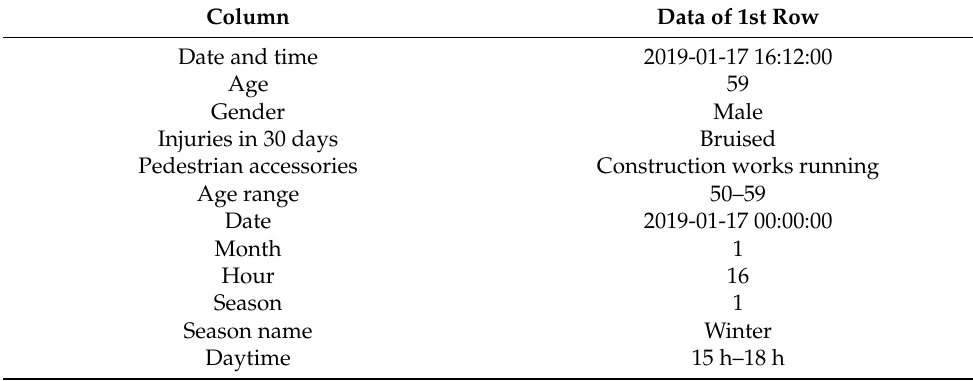
Table 13. Pedestrians involved data schema after data preparation.